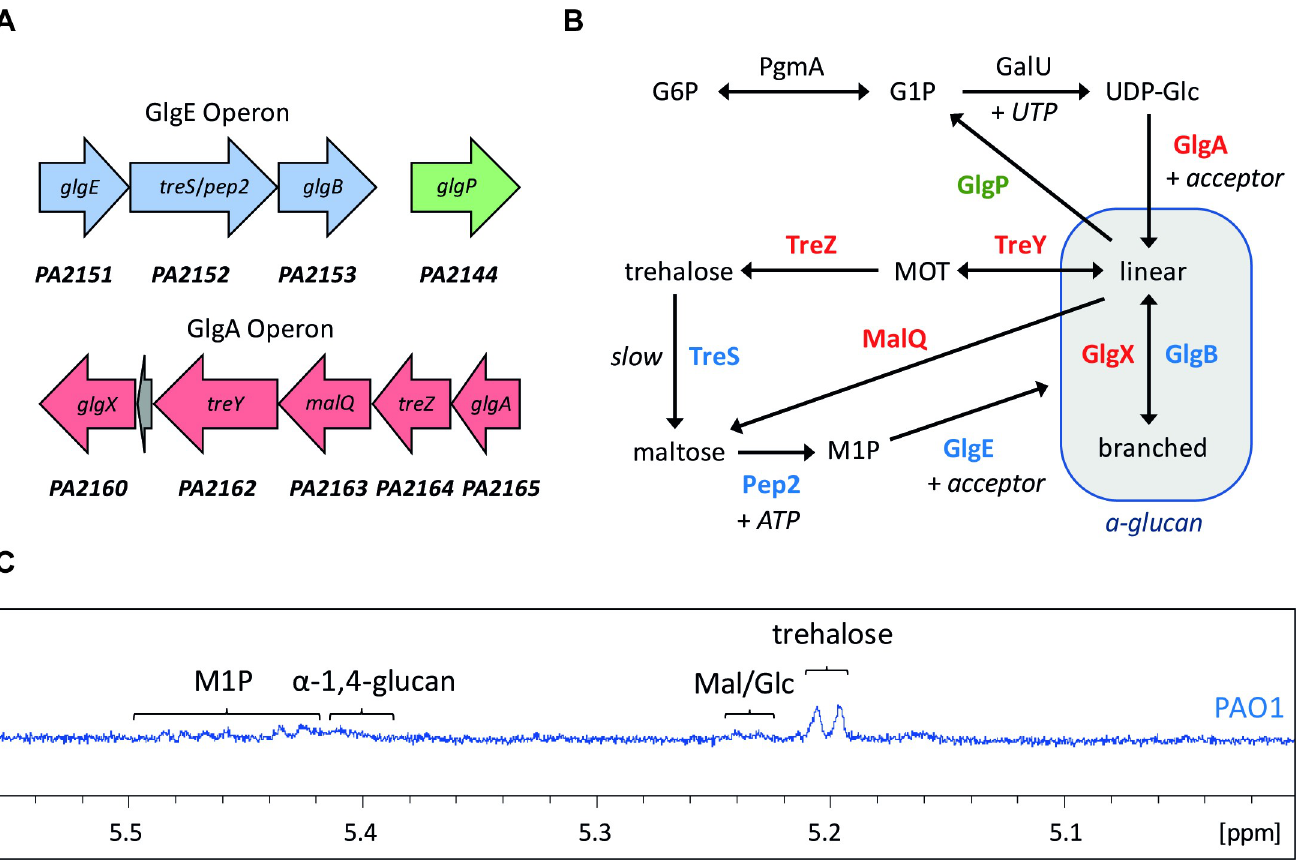
names correspond to the operons shown in 1A. Arrows indicate the primary direction of flux between substrates. Abbreviations are used as follows: G6P –glucose- 6-phosphate, G1P –glucose-1-phosphate, UDP-Glc–UDP-glucose, MOT–maltooligosyltrehalose, M1P –maltose-1-phosphate. C) 1 H-NMR spectrum for PAO1. Peaks corresponding to key metabolites are indicated. Mal/Glc–maltose/glucose.